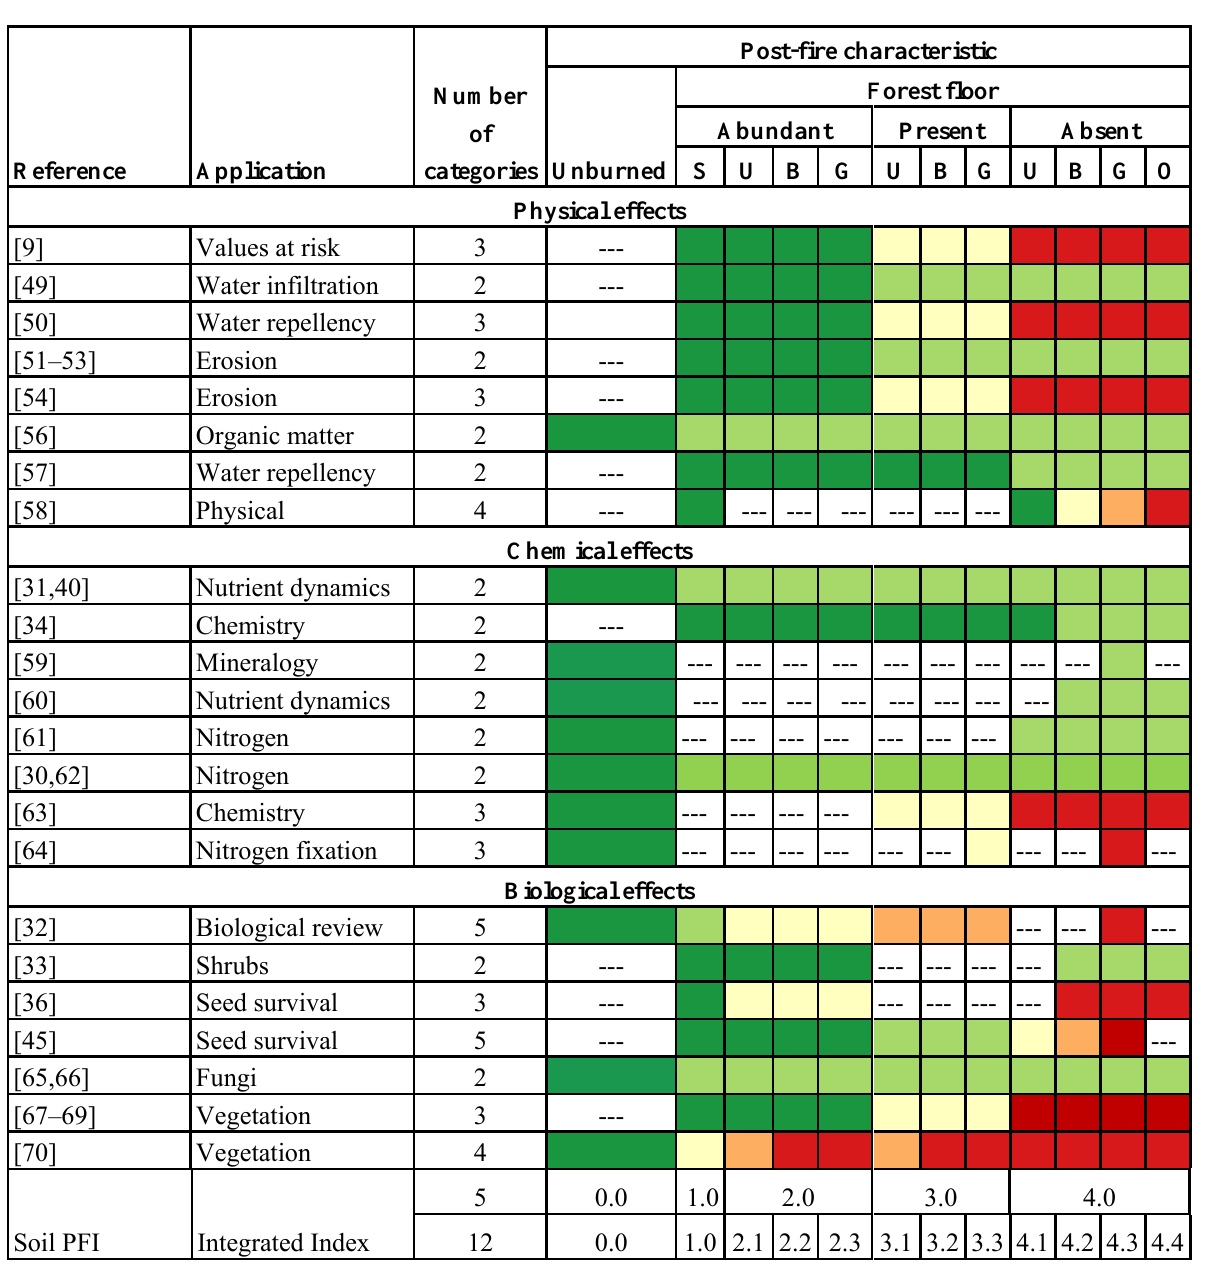
Table 1. Literature compilation of categorizations. We used this compilation to quantify soils after a fire with resulting soil post-fire index (PFI) categories shown on the last line of this table (Table 2 describes the PFI indicators). Different colors ( i.e. , green to red) indicate the defined categories included in the publication while non-shaded cells (---) denote an outcome that was not included. Post-fire characteristics most noted had two primary indicators. First, the amount of surface organics (e.g., litter, humus, rotten wood) present, expressed as abundant , present , or absent on the forest floor. Second, whether the litter is scorched (S) and the state of the exposed mineral soil: unburned (U) , blackened from combustion (B) , gray/white (G) from ash, or orange (O) from mineralogical